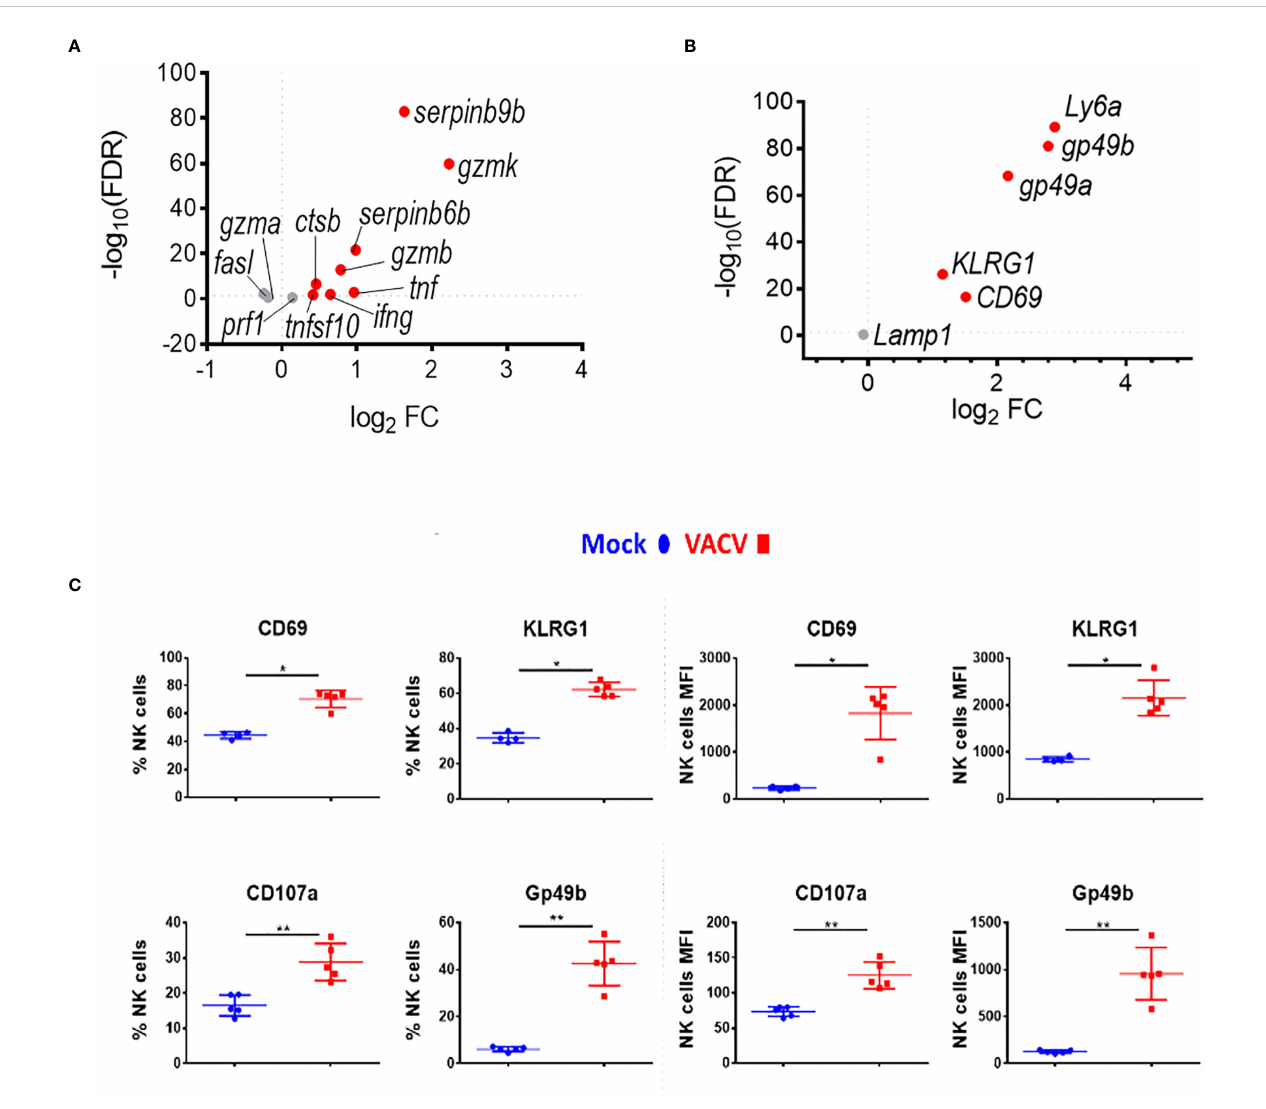
FIGURE 3 NK cells become activated and upregulate key effector mechanisms during VACV infection. C57BL/6 mice were infected i.n. with VACV or were mock- infected with vehicle control for 6.5 d at which time NK cells were isolated for bulk RNA-seq (n=4) or fl ow cytometry (n=5). (A) The differential expression of effector proteins transcripts (VACV vs mock) was analysed by RNA-seq. Each dot represents a transcript. Red indicates statistical signi fi cance. Fold change (FC) is shown on the a axis and false discovery rate (FDR) on the Y axis (FDR<0.05). (B) Differential expression of activation marker transcripts (VACV vs mock). (C) Quanti fi cation of NK cell surface activation markers in mock (blue) and VACV-infected mice (red) by fl ow cytometry. NK cells expressing the indicated marker by percentage and MFI are shown. Error bars represent ± SD. Statistical signi fi cance was calculated using a Mann-Whitney test (*p < 0.05, ** p <